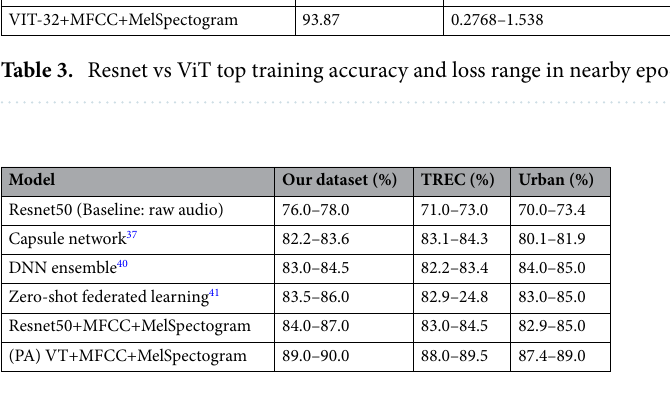
Table 4. Comparison of our proposed approach with state of the art algorithms (testing accuracy range), on different available datasets.